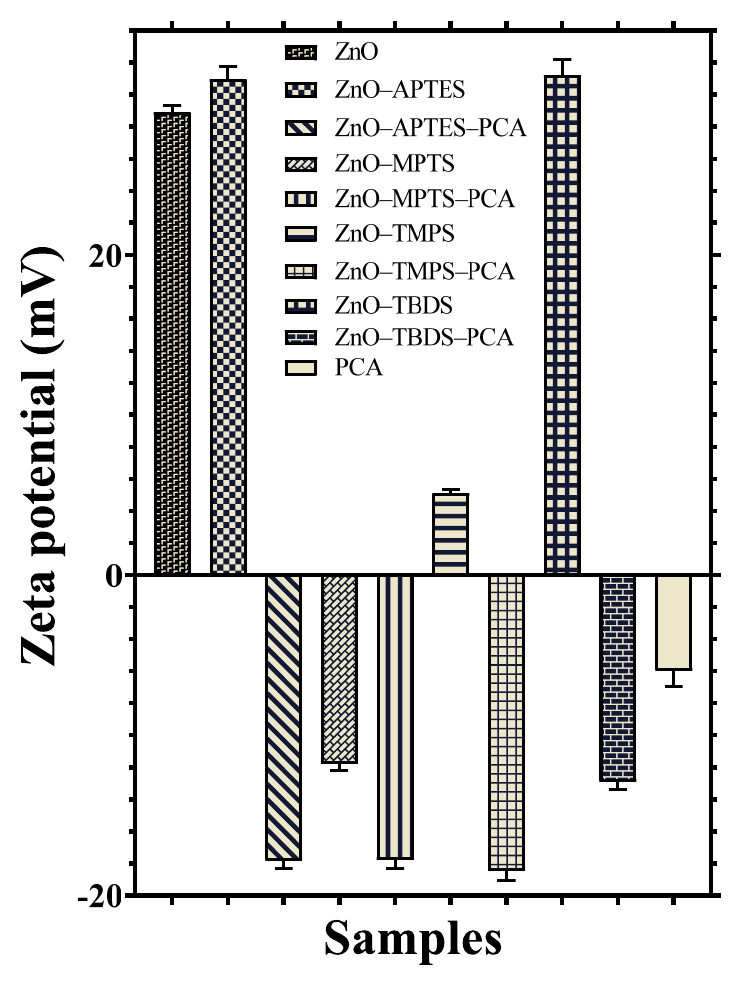
Figure 6. Zeta potential measurements in deionized water for all prepared materials before surface modification and after, along with PCA prodrug-loaded nanoformulations. The measurements were performed for all materials suspended in deionized water at pH 7.4.